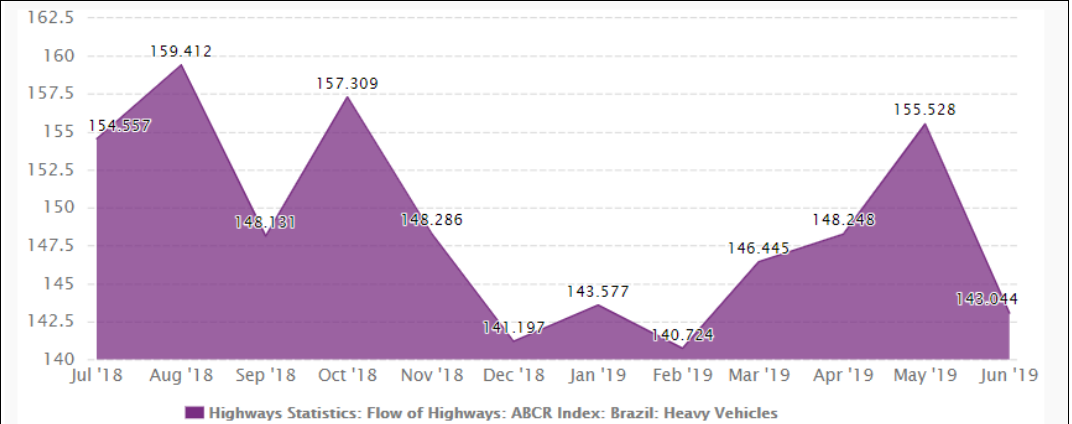
Figure 1. Brazil ’ s flow of highways from Jan 1999 to Jun 2019 (CEICDATA, 2020)